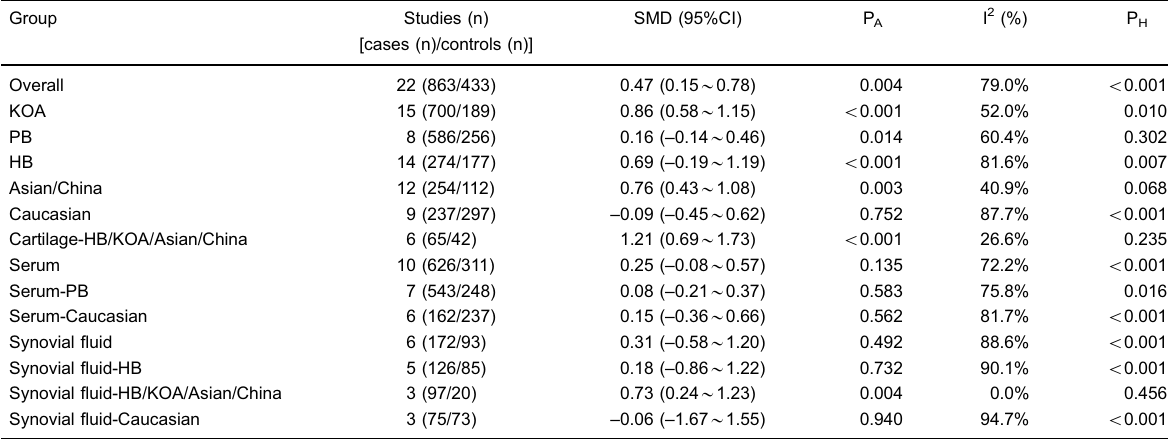
Table 2. Pooling analysis of matrix metalloproteinase-1 level and osteoarthritis